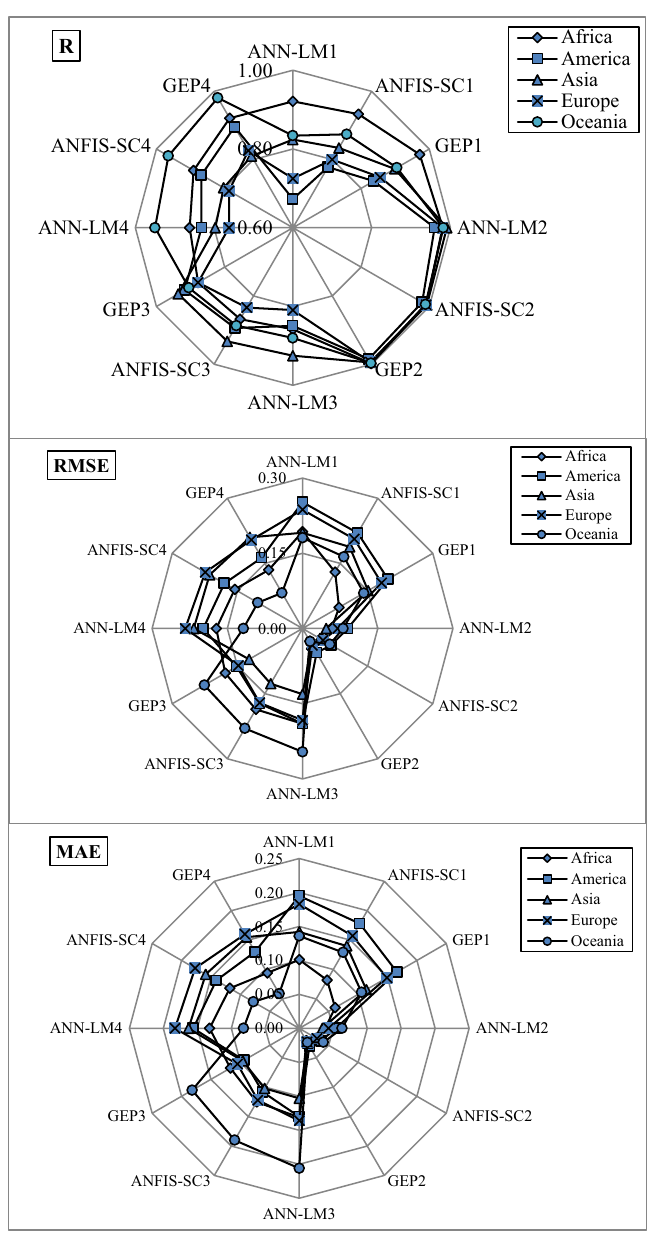
Figure 11. Comparison of R , RMSE and MAE values corresponding to the soft computing